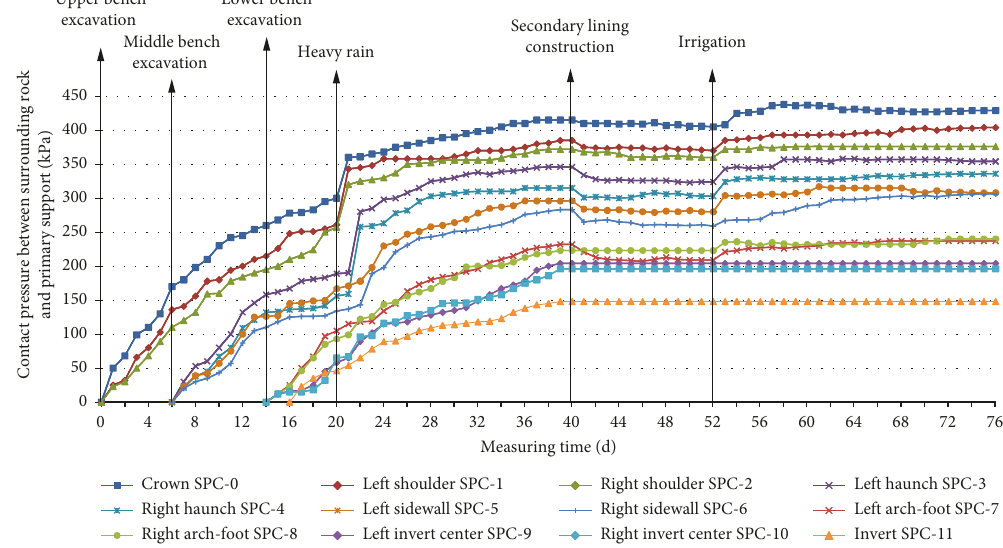
Figure 12: Monitoring results of the contact pressure.